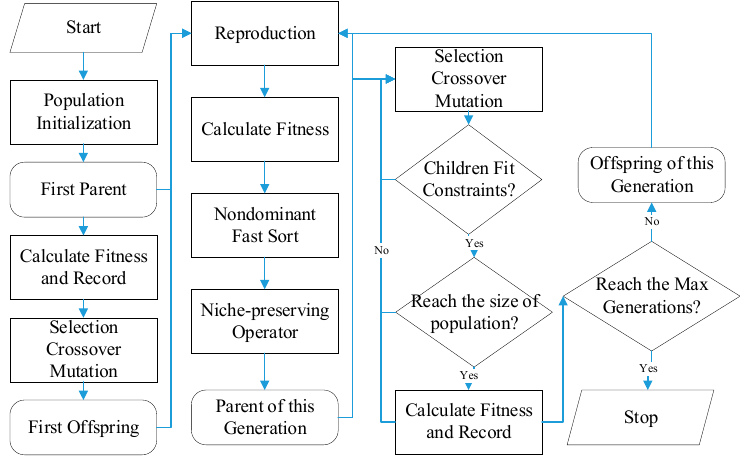
Figure 3. Flowchart of the optimization approach.